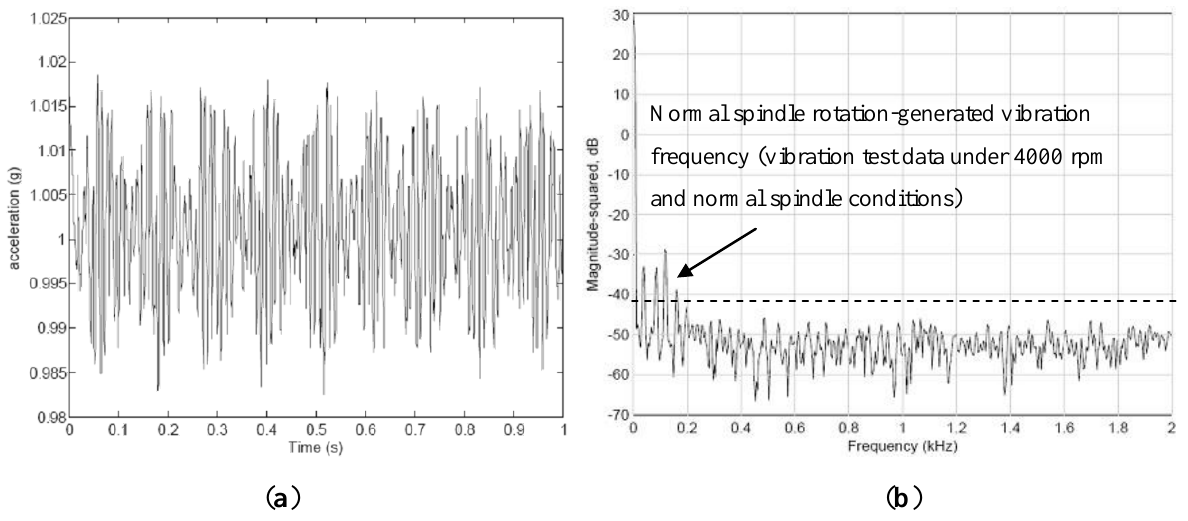
Figure 7. The time domain and spectrum of vibrations when the spindle